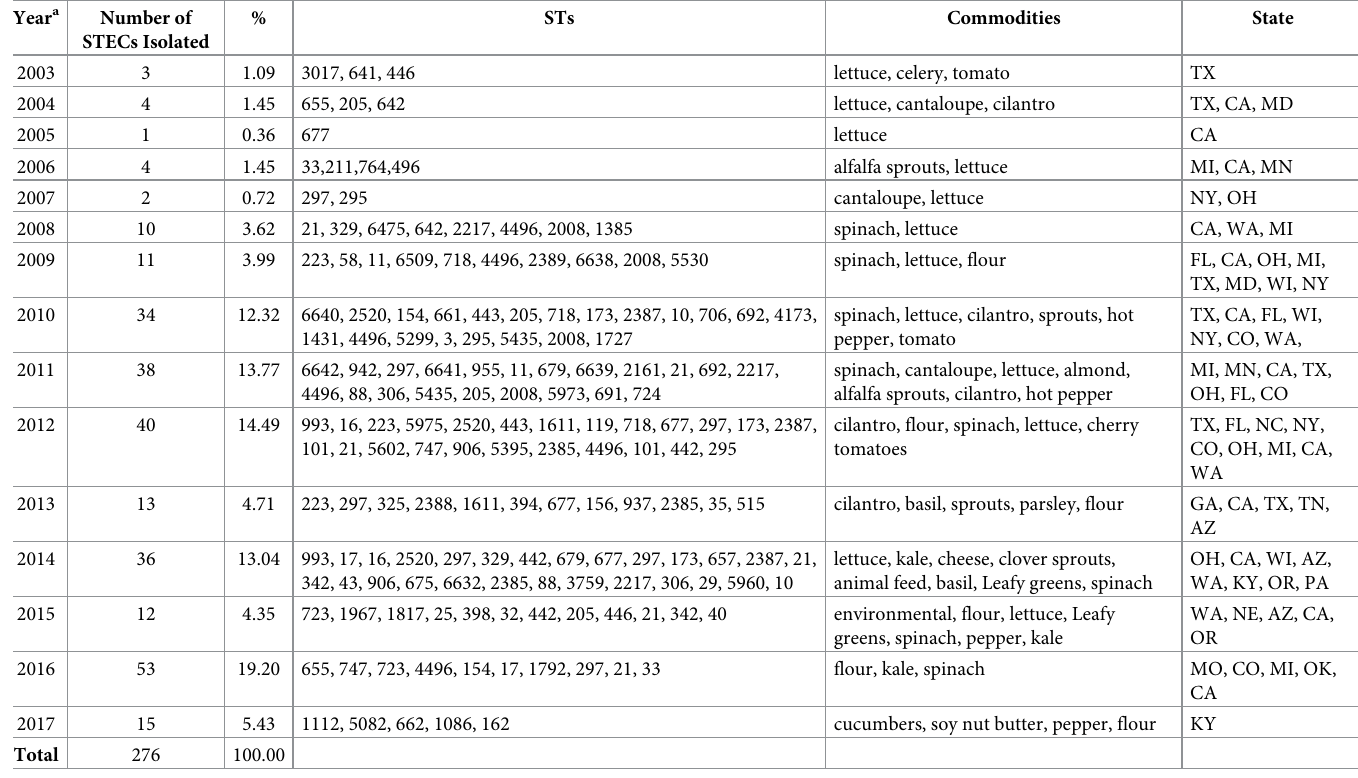
Table 2. Frequency of STECs isolated from FDA regulated food commodities per year from 2010–2017.